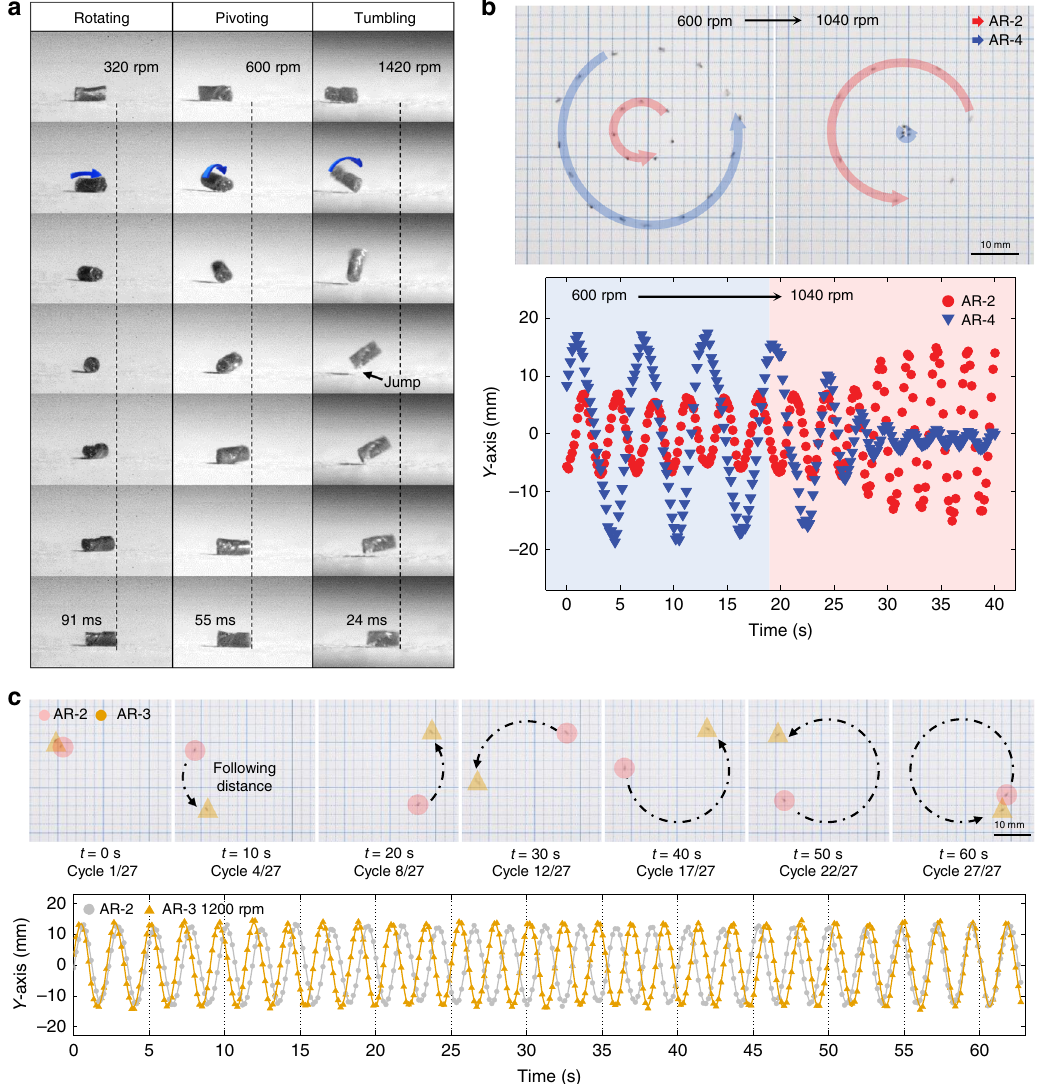
Fig. 2 Regulation of orbital radius and velocity via rotational magnetomotility. a Evolution of three rotational modes of AR-2 amid half turn rotation upon magnetic speed manipulation. b Transferable orbital maneuver in a two-body system, including overlaid images (top) and y -axis displacement (bottom). c Time-lapsed trajectory showing that a faster spinbot catches up to a slightly slower spinbot via 27 orbital motions (top). The solid line in the graph refers to y = R sin( θ ), when R is the average orbital radius of the spinbots and θ is the radian over time